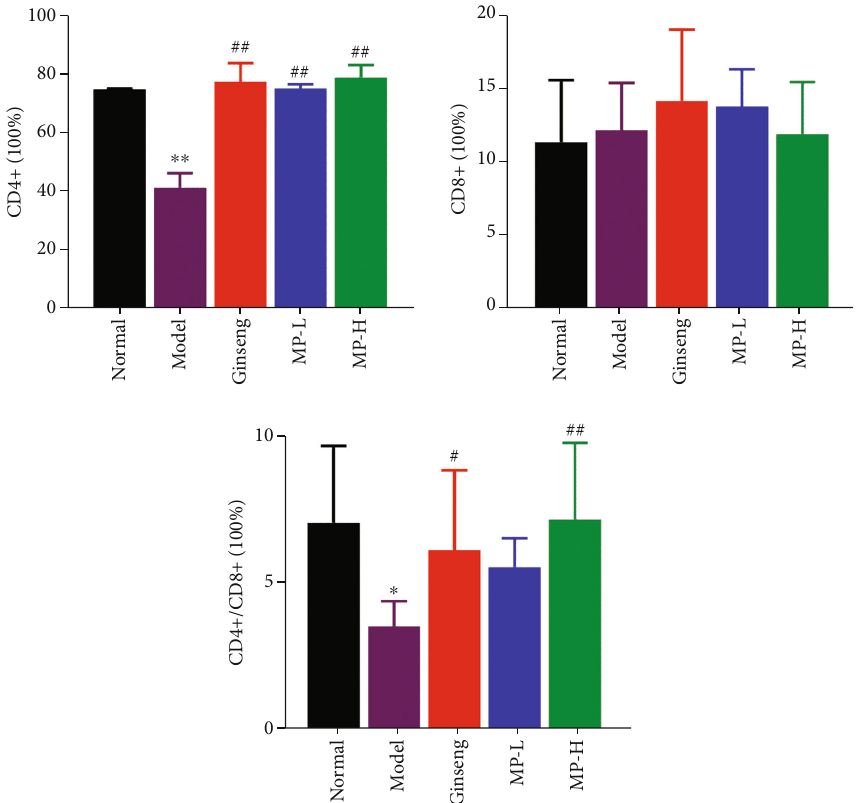
Figure 6: E ff ects of Maca polysaccharides on CD4+ T cells and CD8+ T cells ( n = 12 ); ∗ p < 0 : 05 and ∗∗ p < 0 : 01 vs. control group; # p < 0 : 05 and ## p < 0 : 01 vs. model group.